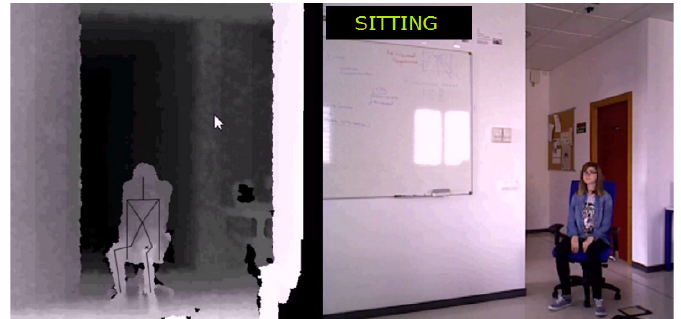
Figure A1. Sitting posture detection.